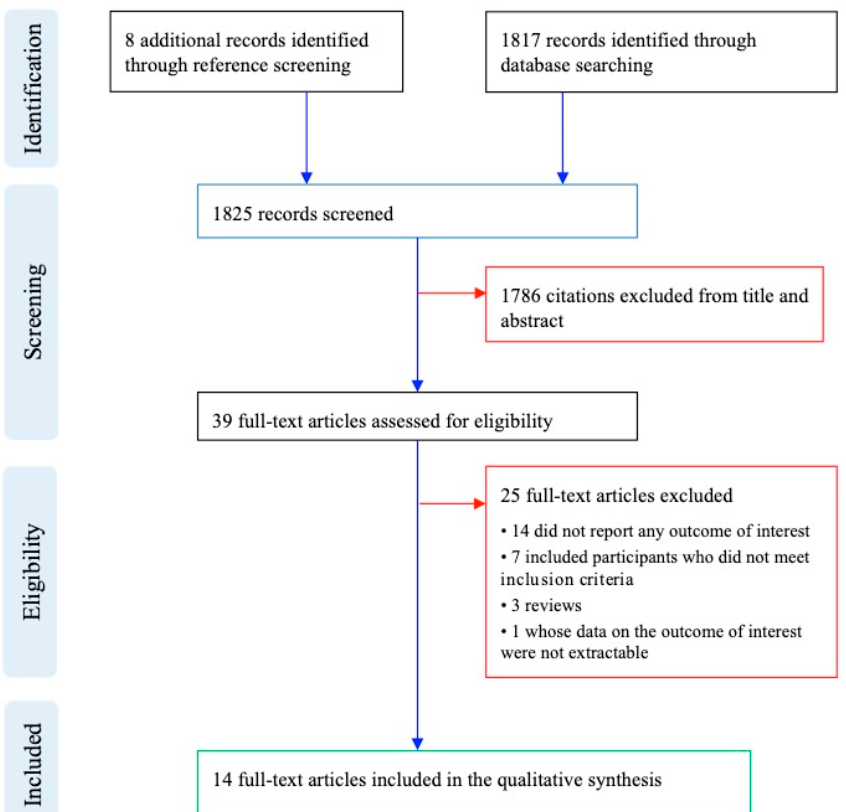
Figure 1. Flow Figure 1. Flow chart.